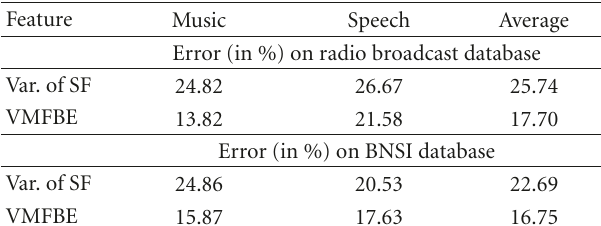
Table 4: Results for discrimination ability with a shorter variance calculation window (200